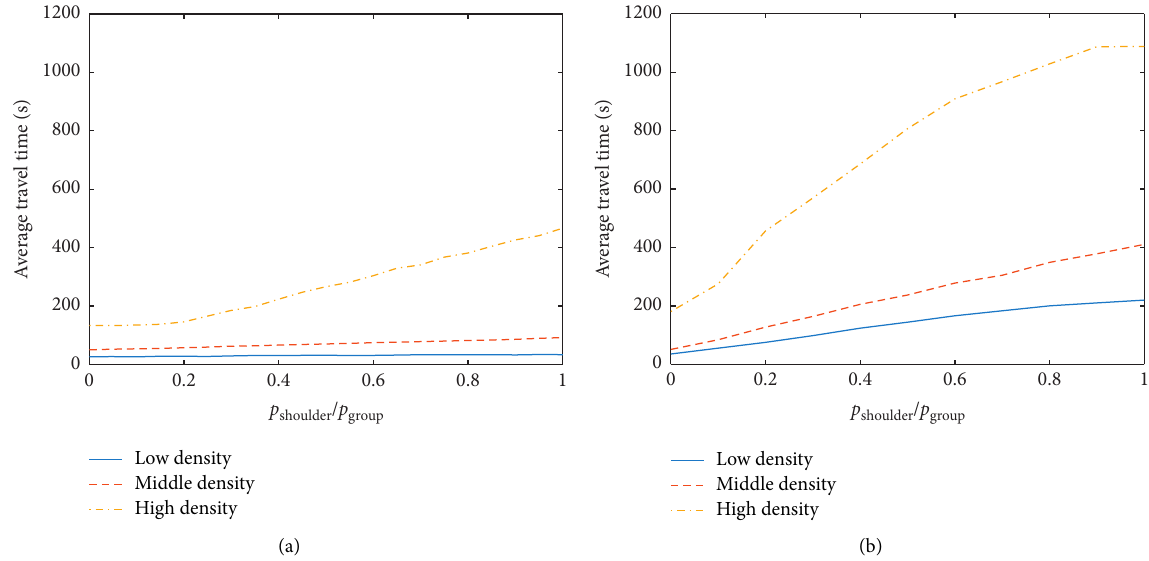
Figure 13: The average travel time under different shoulder group probabilities. The group sizes in (a) and (b) are, respectively, two and three.